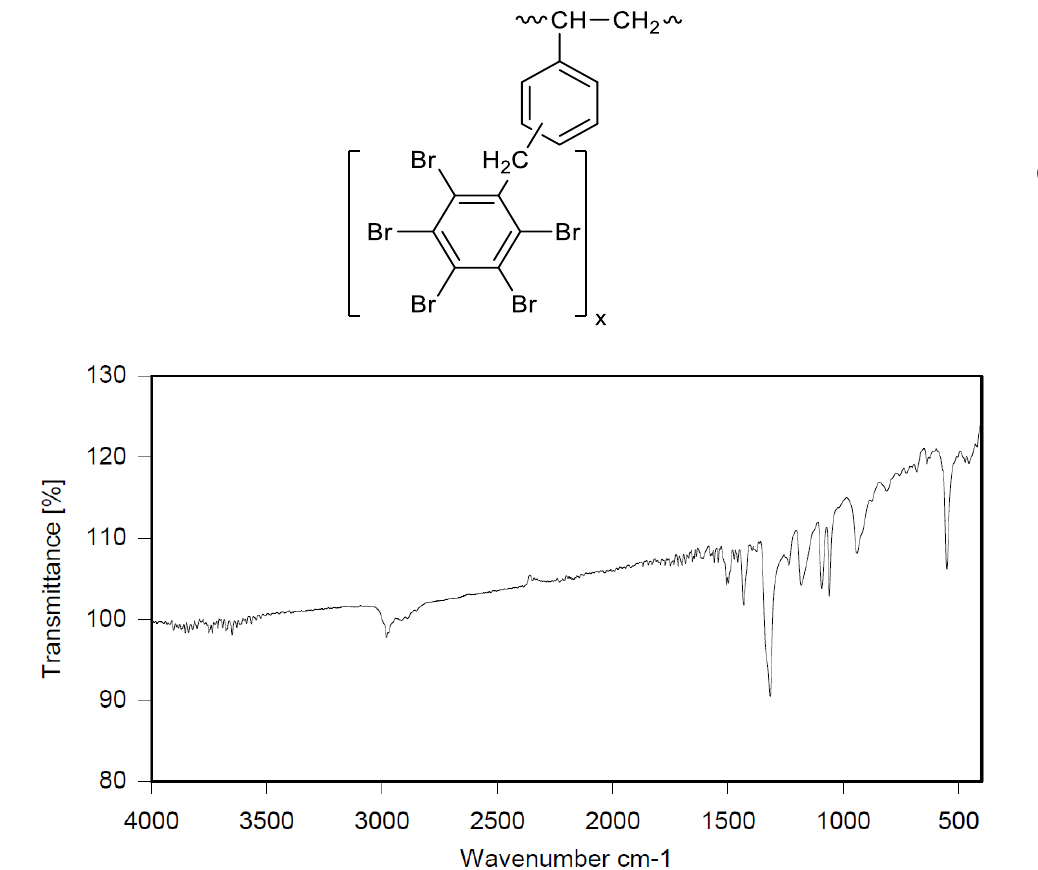
Figure 6. FTIR spectrum of polystyrene alkylated with PBBB (PS-PBBB).